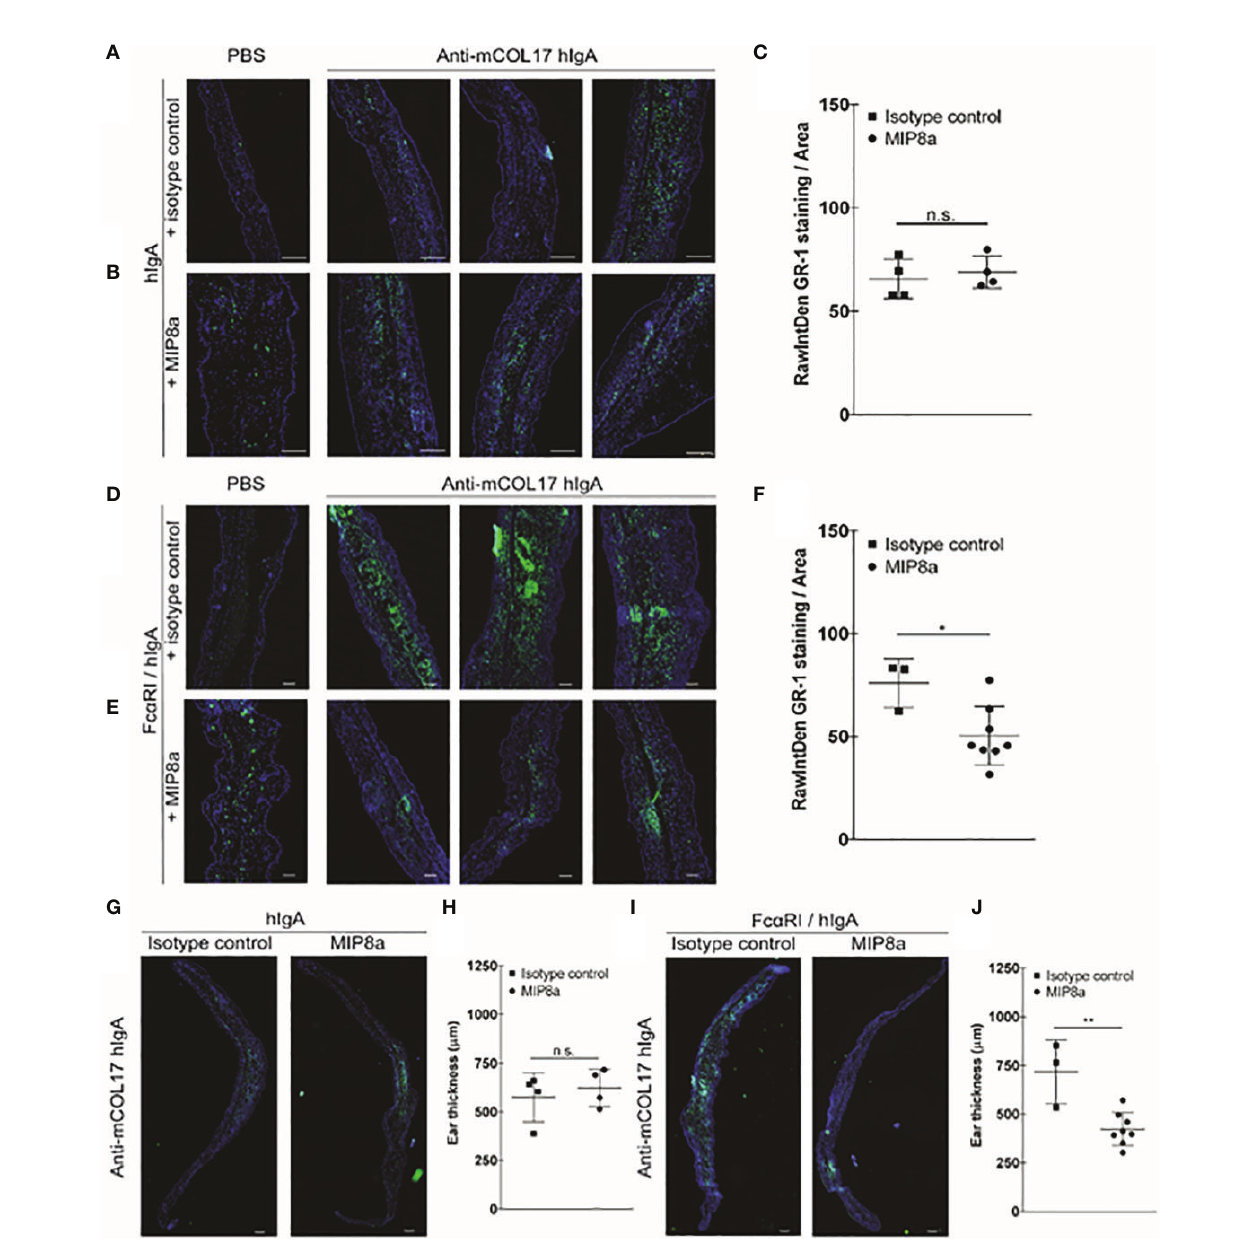
FIGURE 4 | Blocking Fc a RI prevents lgA-induced neutrophil accumulation and thickening ears. (A, B) hlgA and (D, E) Fc a RI/hlgA mice were injected with PBS (left panels) or anti-mCOL17 hlgA (right panels, 3 examples) every other day till sacri fi ce on day 7 (in total 4 injections) in combination with a (A, D) isotype control antibody or (B, E) anti-Fc a RI mAb MIP8a (C, F) Quanti fi cation of GR-1 staining. (G, I) Analysis of ear thickness of (G) hlgA or (I) Fc a RI/hlgA mice after treatment with an isotype control (left panel) or MIP8a (right panel). A representative example of a mouse ear cryosection is shown. (H, J) Quati fi cation of ear thickness. Each dot represents one mouse. hlgA mice (isotype control or MIP8a) n = 4; Fc a RI/hlgA mice (isotype control) n = 3; Fc a RI/hlgA mice (MIP8a) n = 8. Cryosection of ears were stained with the neutrophil marker GR-1 (green) and DAPl (DNA; blue). Scale bars: 250 m m (A, B, G, I) or 100 m m (D, E) . Data are presented as mean ± SD. Student ’ s t test; *p < 0.05, **p < 0.001. n.s., not signi fi